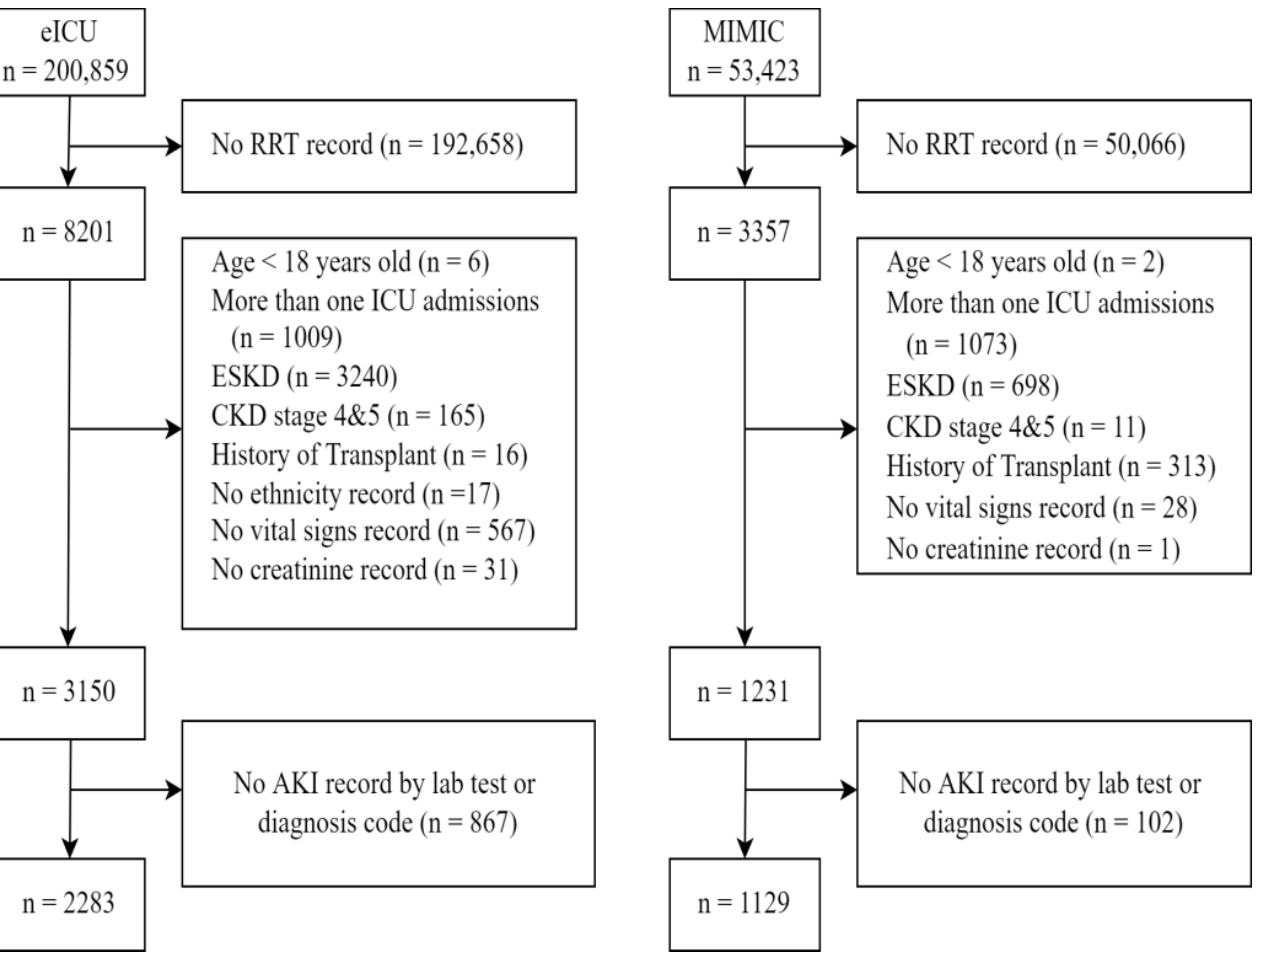
Figure 2. Participant flow diagram. n is patient unit encounter.